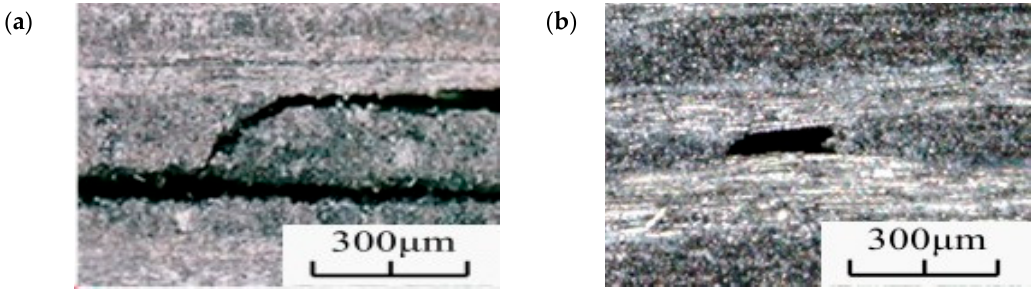
Figure 9. Fracture morphology of the CFRP specimen in ( a ) the HCF and ( b ) the VHCF regime.